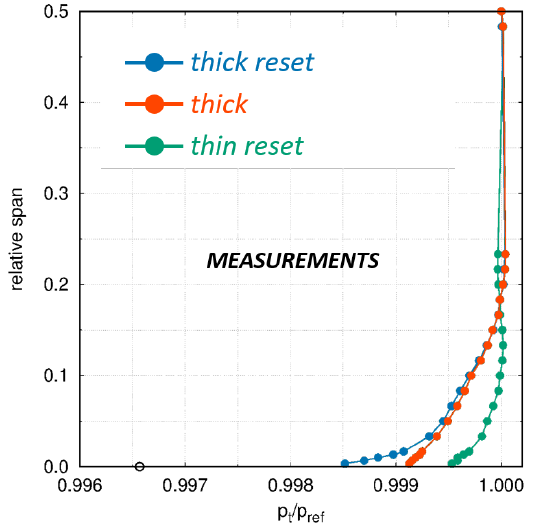
Figure 16. Different BL profiles generated at the cascade